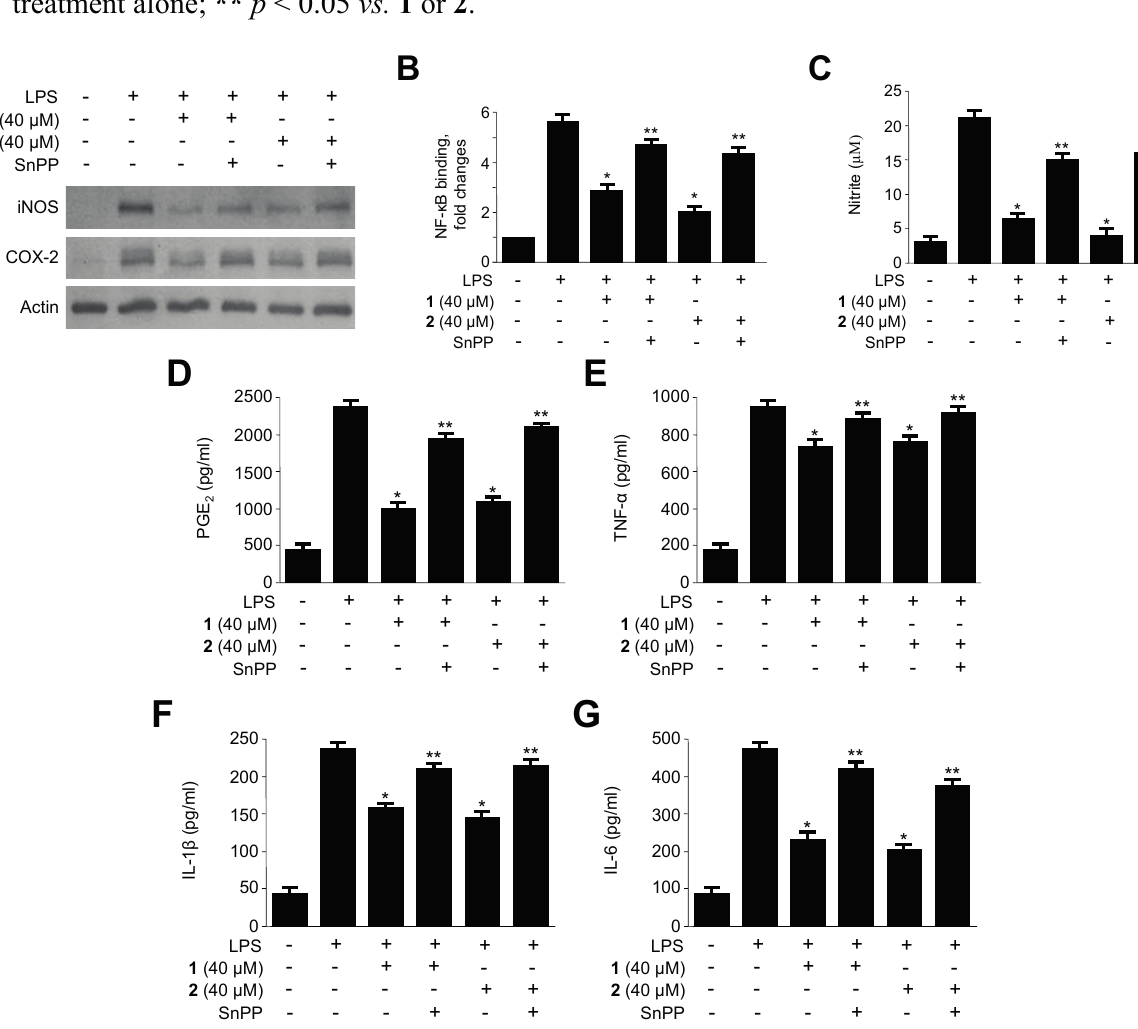
Figure 7. Effects of tin protoporphyrin IX (SnPP) on 1 - and 2 -mediated inhibition of inducible nitric oxide synthase (iNOS) and (cyclooxygenase-2) COX-2 protein expression ( A ); nuclear factor- κ B (NF- κ B) DNA-binding activity ( B ); nitrite, prostaglandin E 2 (PGE 2 ), tumor necrosis factor- α (TNF- α ), interleukin-1 β (IL-1 β ), and interleukin-6 (IL-6) production ( C – G ) in RAW264.7 macrophages stimulated with lipopolysaccharide (LPS). Cells were pretreated with 1 and 2 for 12 h in the presence or absence of SnPP (50 μ M), and then stimulated with LPS (1 μ g/mL) for 18 h ( A and C – G ) or for 30 min ( B ). Western blot analysis was representative of three independent experiments with similar results. Data are represented as the mean ± S.D. of three independent experiments. * p < 0.05 vs. LPS treatment alone; ** p < 0.05 vs. 1 or 2